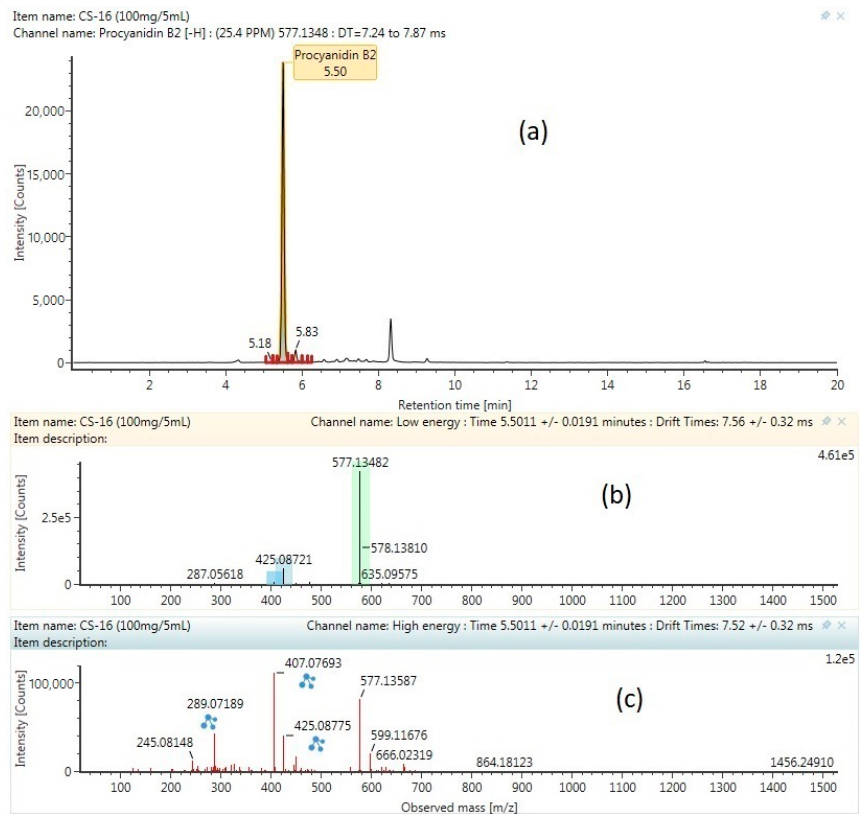
Figure 4. MSCE negative ion mode product of procyanidin B2 compound: ( a ) chromatogram mass spectrum; ( b ) Low energy of mass spectrum; ( c ) high energy of mass spectrum.